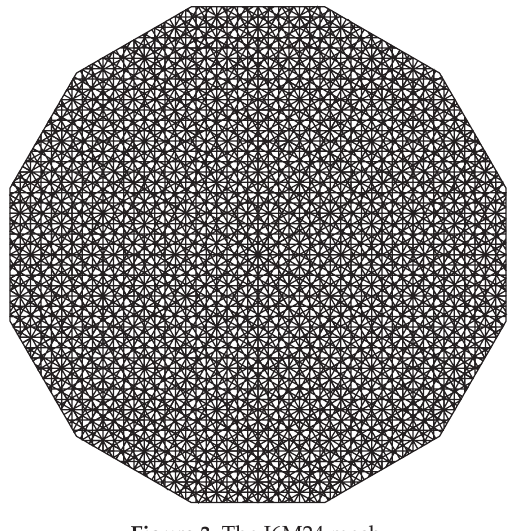
Figure 3: The J6M24